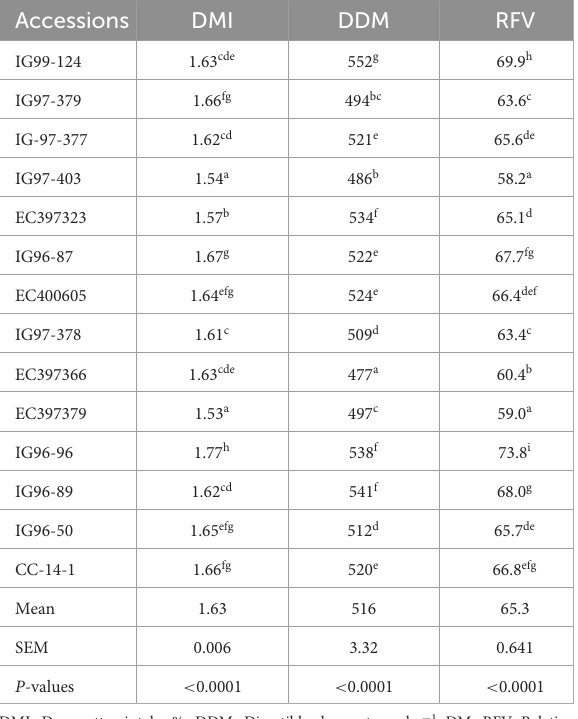
TABLE 6 Palatability attributes of sugar-rich Cenchrus ciliaris